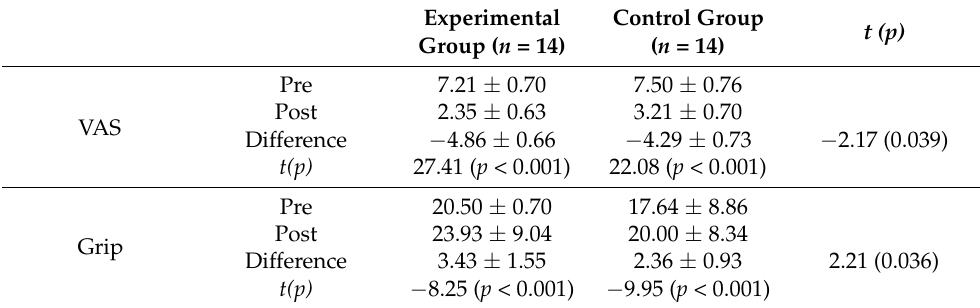
Table 2. Changes in pain and grip strength before and after treatment ( n =